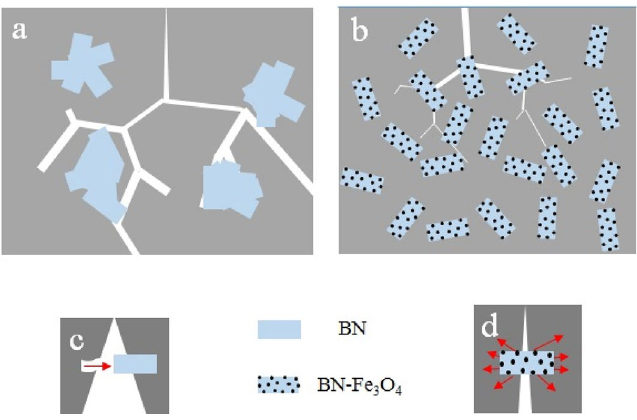
Figure 8. Schematic of crack growth in cement containing BN and BN–Fe 3 O 4